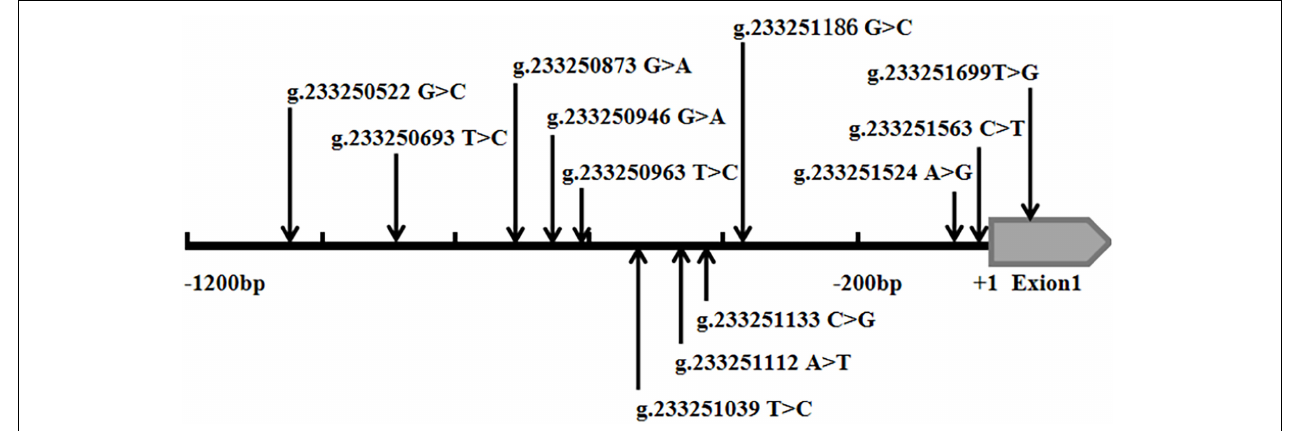
FIGURE 1 | Schematic diagram of gene mutation site of ATG16L1 gene promote. The DSVs and SNPs in the ATG16L1 gene promoter identified in AMI patients and controls. Schematic representation of the DSVs within the ATG16L1 gene promoter. The numbers represent the genomic DNA sequences of the human ATG16L1